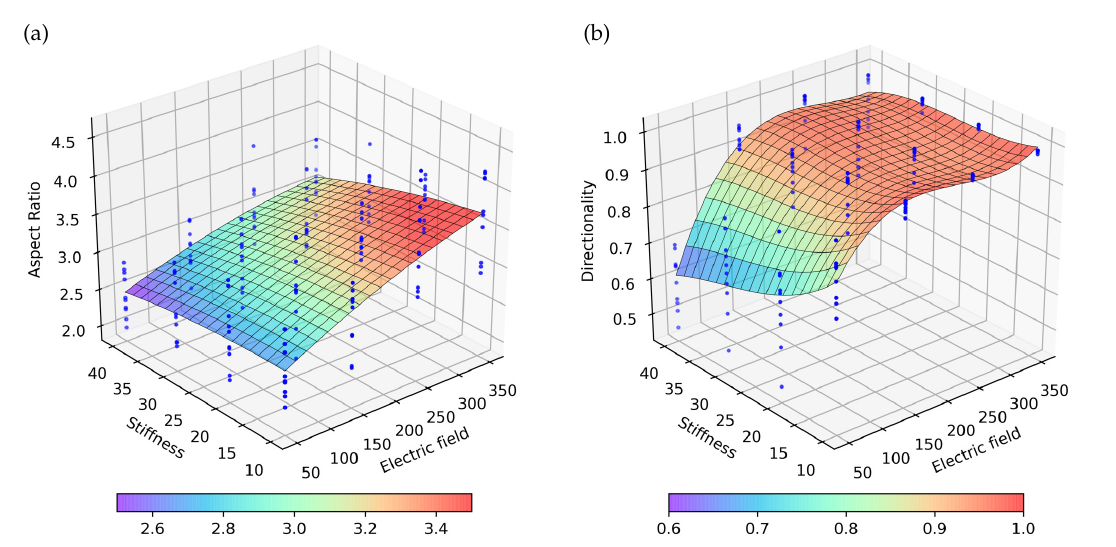
Figure 11. Representation of the obtained numerical results by applying an alternating electric field with different intensities in ECM with different stiffnesses. Blue dots represent 10 experiment repetitions, on which the surface with the best fit to the results is represented. ( a ) Aspect ratio for the different combination of stiffness and electric stimulus. ( b ) Directionality for the different combination of stiffness and electric